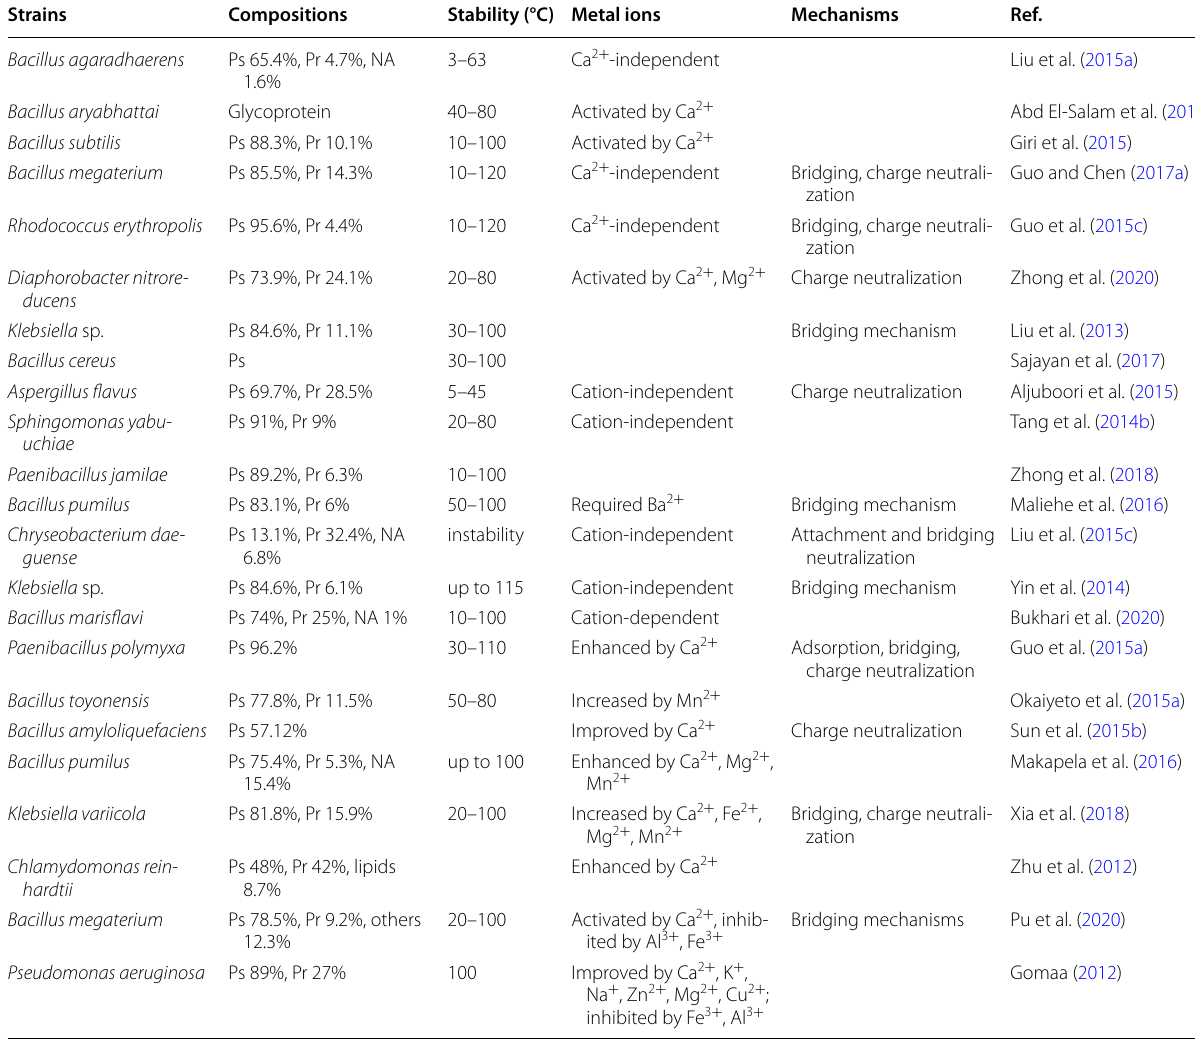
Table 3 Correlation between composition of microbial flocculant with its thermal stability, metal ion dependence and flocculating